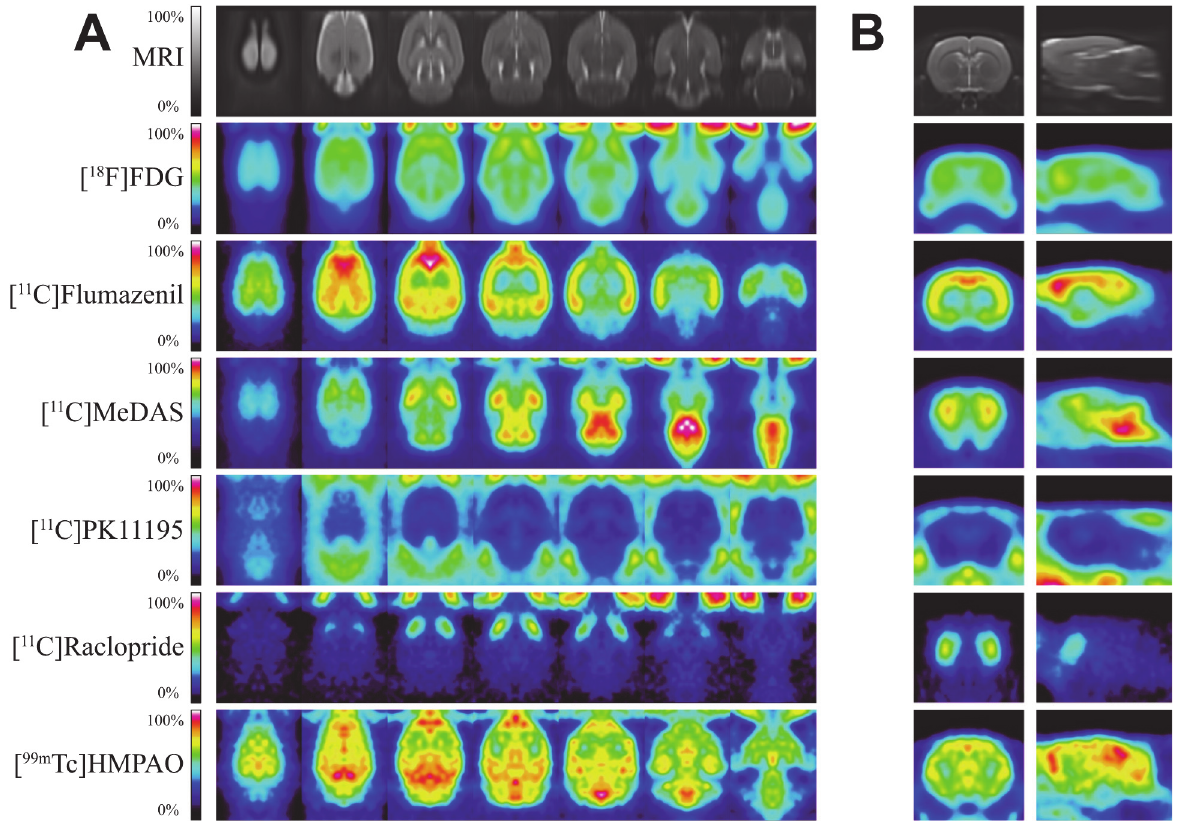
Fig 2. Tracer-specific PET and SPECT templates. (A) Different horizontal brain sections, and (B) sagittal and coronal sections.